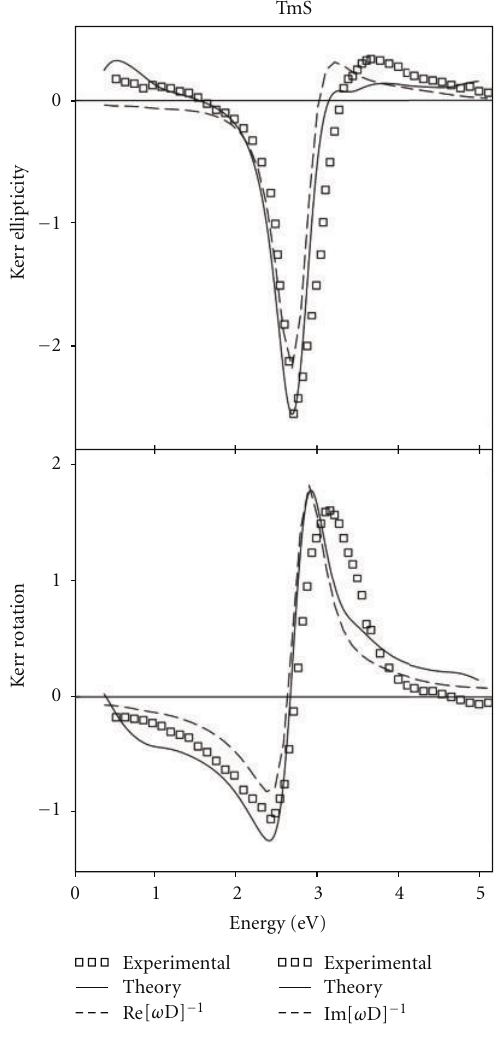
Figure 67: Calculated Kerr rotation and Kerr ellipticity spectra (in degree) for TmS in the LSDA+ U approximation, and real and the imaginary parts of the function [ ω D( ω )] − 1 [384] compared with experimental data